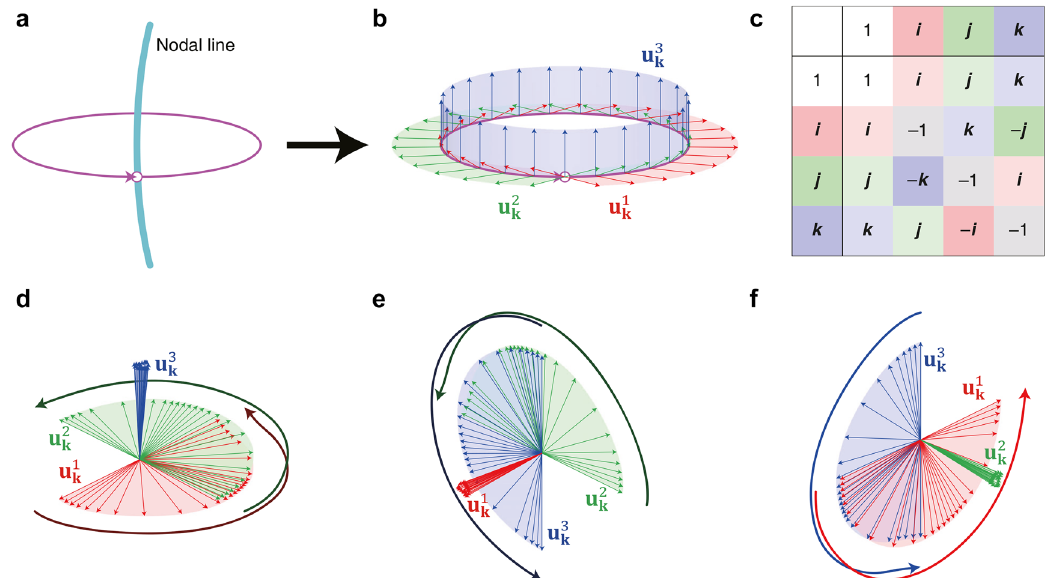
Figure 3: Schematics of the non-Abelian quaternion charges. multiplication table. (d)–(f) Eigenstates gathered at the origin indicating the topological charges + k , + i , and + j , respectively. where the components of 𝝈 = matrices and t = ( − i ∕ 2) 𝝈